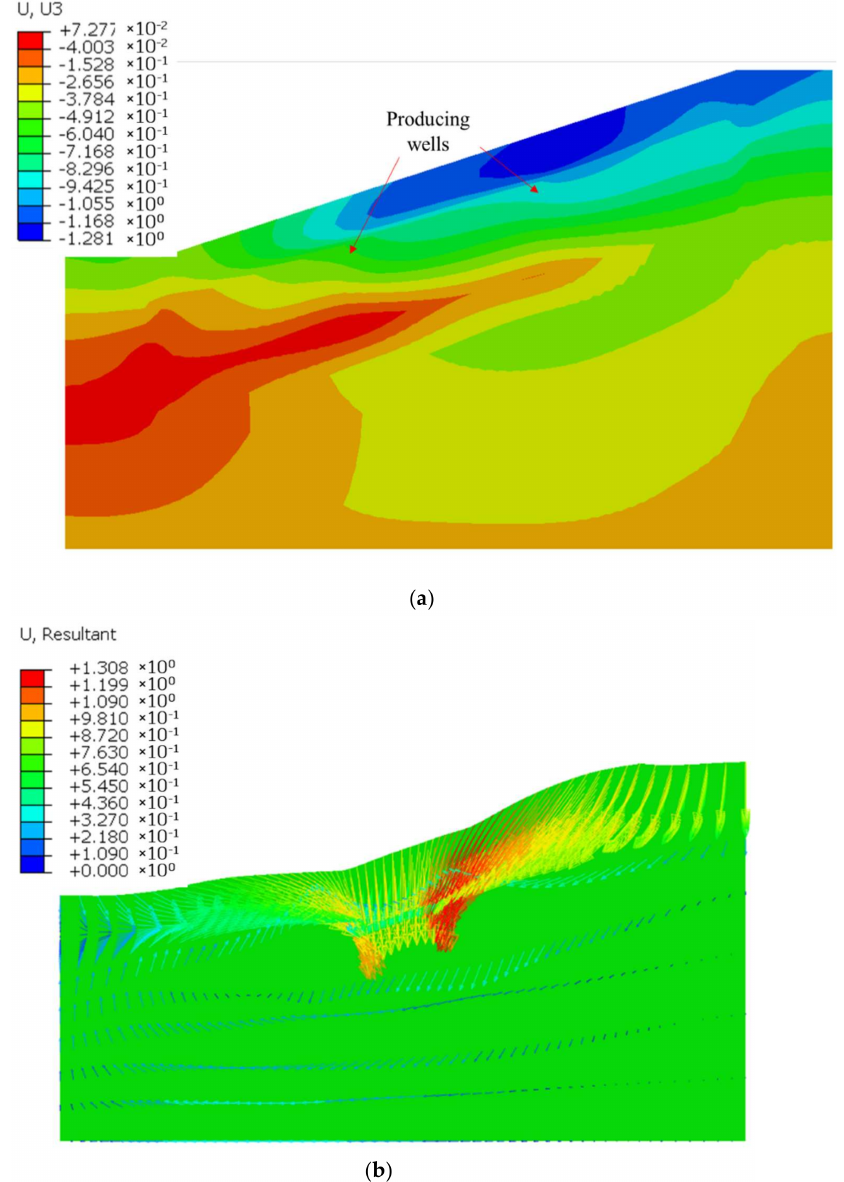
Figure 6. Vertical displacement and total displacement vector. ( a ) Displacement (decomposition range: 150 m). ( b ) Displacement